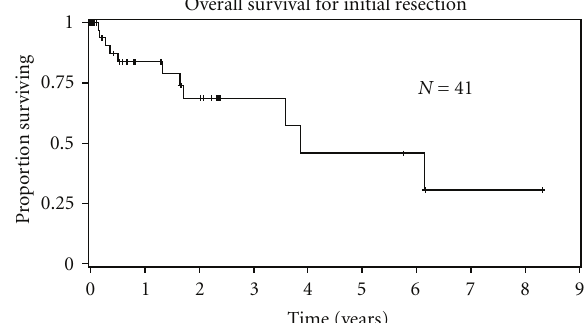
Figure 1: Overall survival of 41 patients with initial resection of primary retroperitoneal